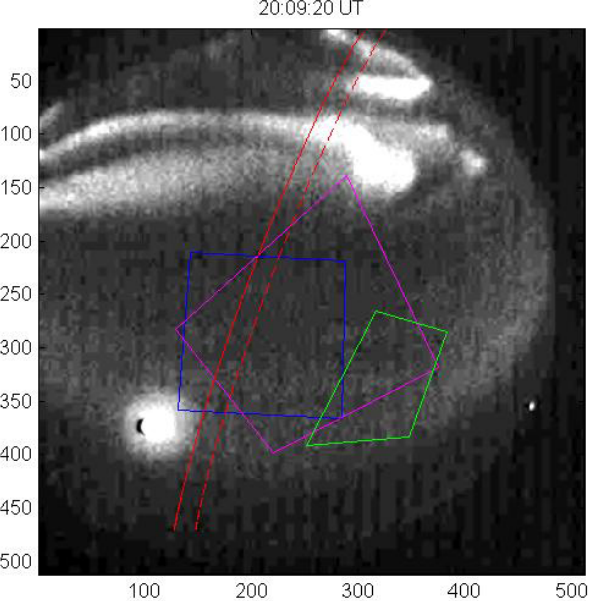
Fig. 3. The FMI camera image at 20:09:20UT. Colour frames show projections of ALIS camera fields of view at 110km. Blue – Abisko, magenta – Nikkaluokta, green – Silkkimuotka. The solid red line shows the FAST footprint. The dashed red line indicates the line along which the keogram in Fig. 2 was obtained. This shift- ing was done to avoid the influence of the moon (the bright spot in lower left